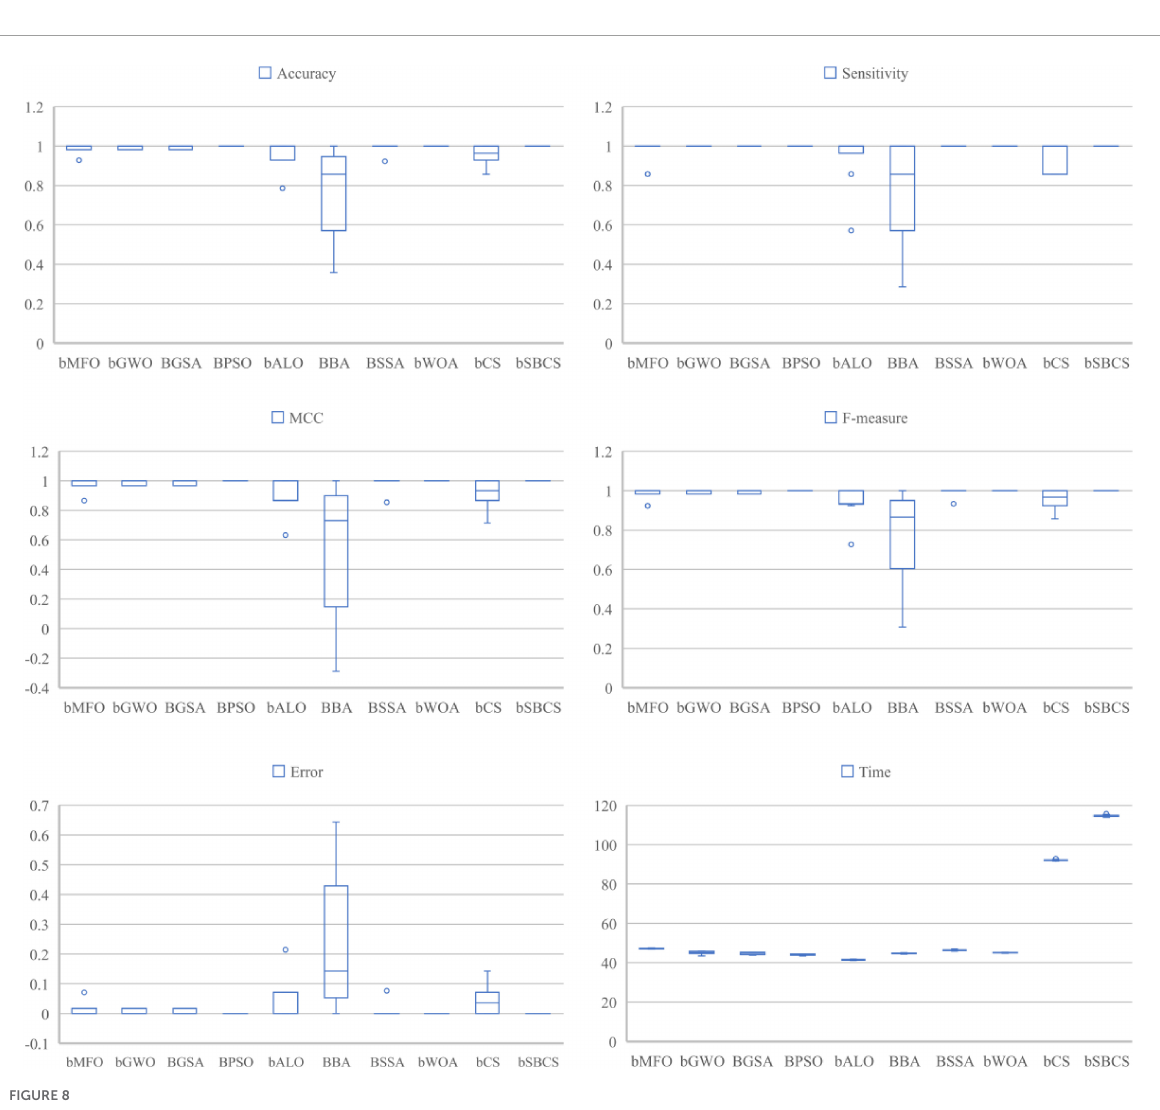
FIGURE8 Comparison results of SBCS and other swarm intelligence optimization algorithms.